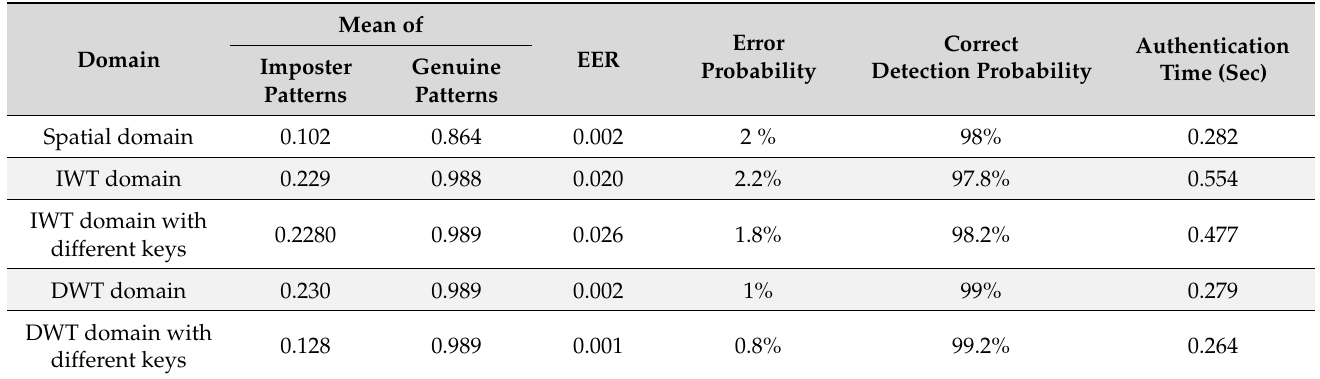
Figure 13. The correlation distributions of genuine and impostor tests using Baker map and an encrypted kernel with ( a ) circular encryption, ( b ) IWT encryption with similar keys for all sub-bands, ( c ) IWT encryption with different keys for all sub-bands, ( d ) DWT encryption with similar keys for all sub-bands, ( e ) DWT encryption with different keys for all sub-bands. Table 3. The encryption domain effect using several